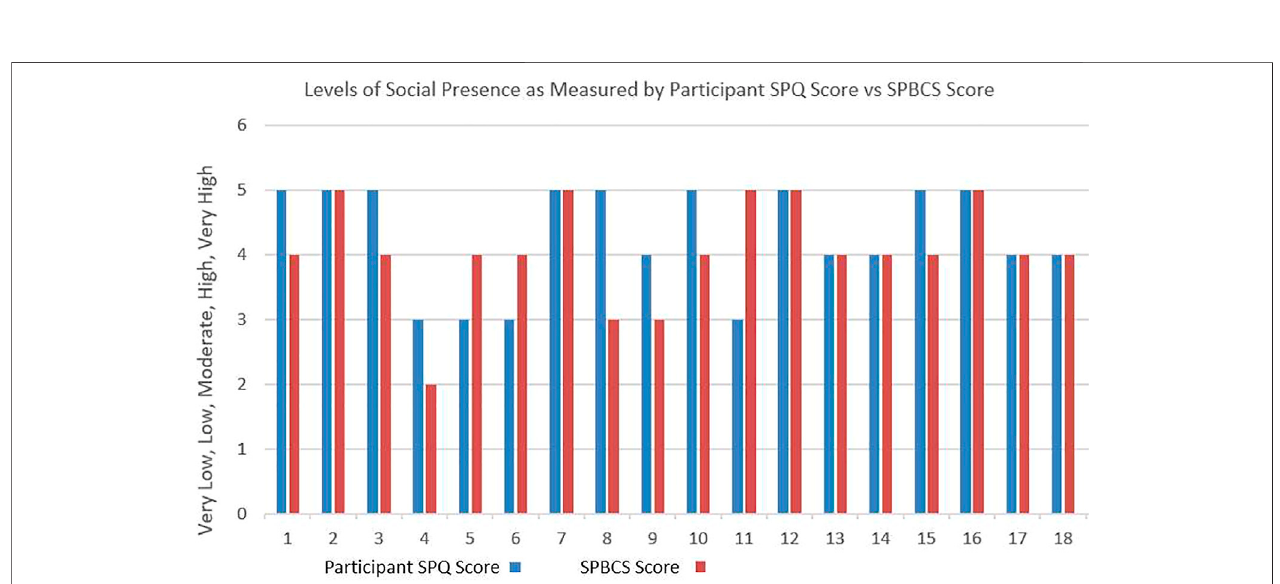
FIGURE 4 | Bar Graph of Levels of Social Presence as Measured by Participant SPQ vs. SPBCS.